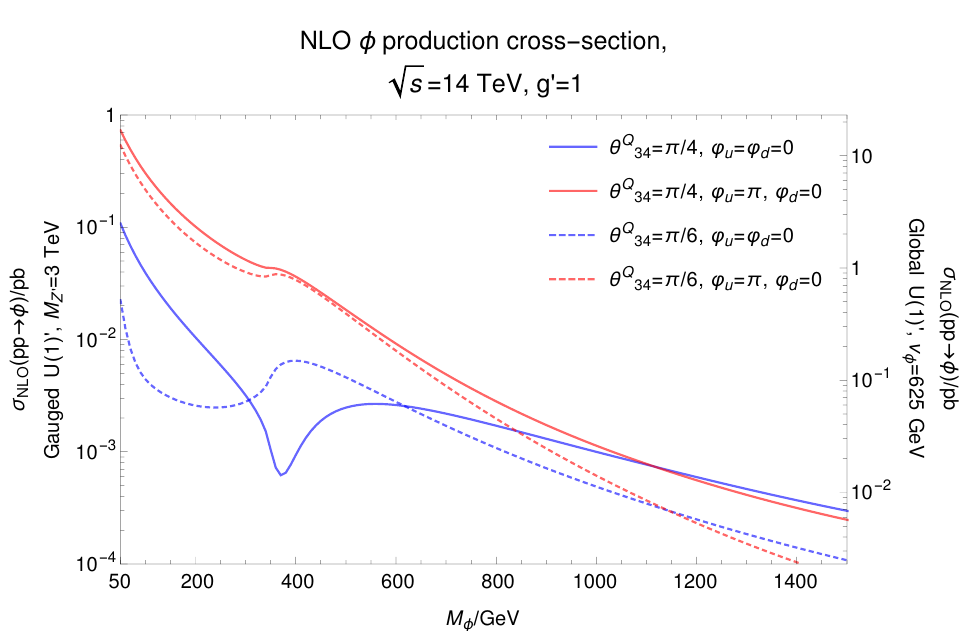
√ Figure 6. Production cross-section of the Yukon φ from ggF at the LHC with s = 14 TeV, via t, T, b, B loops, with parameters: θ Q = π/ 4 in solid and θ Q = π/ 6 in dashed. In blue we plot for 34 34 ( ϕ u = ϕ d = 0) ’ ( ϕ u = 0 , ϕ d = π ) and in red for ( ϕ u = ϕ d = π ) ’ ( ϕ u = π, ϕ d = 0) . The left scale is for the gauge model, M Z 0 = 3 TeV, and the right scale is for the global model, with v φ = 625 GeV. Note that the shape of the curves for the gauge and global models is